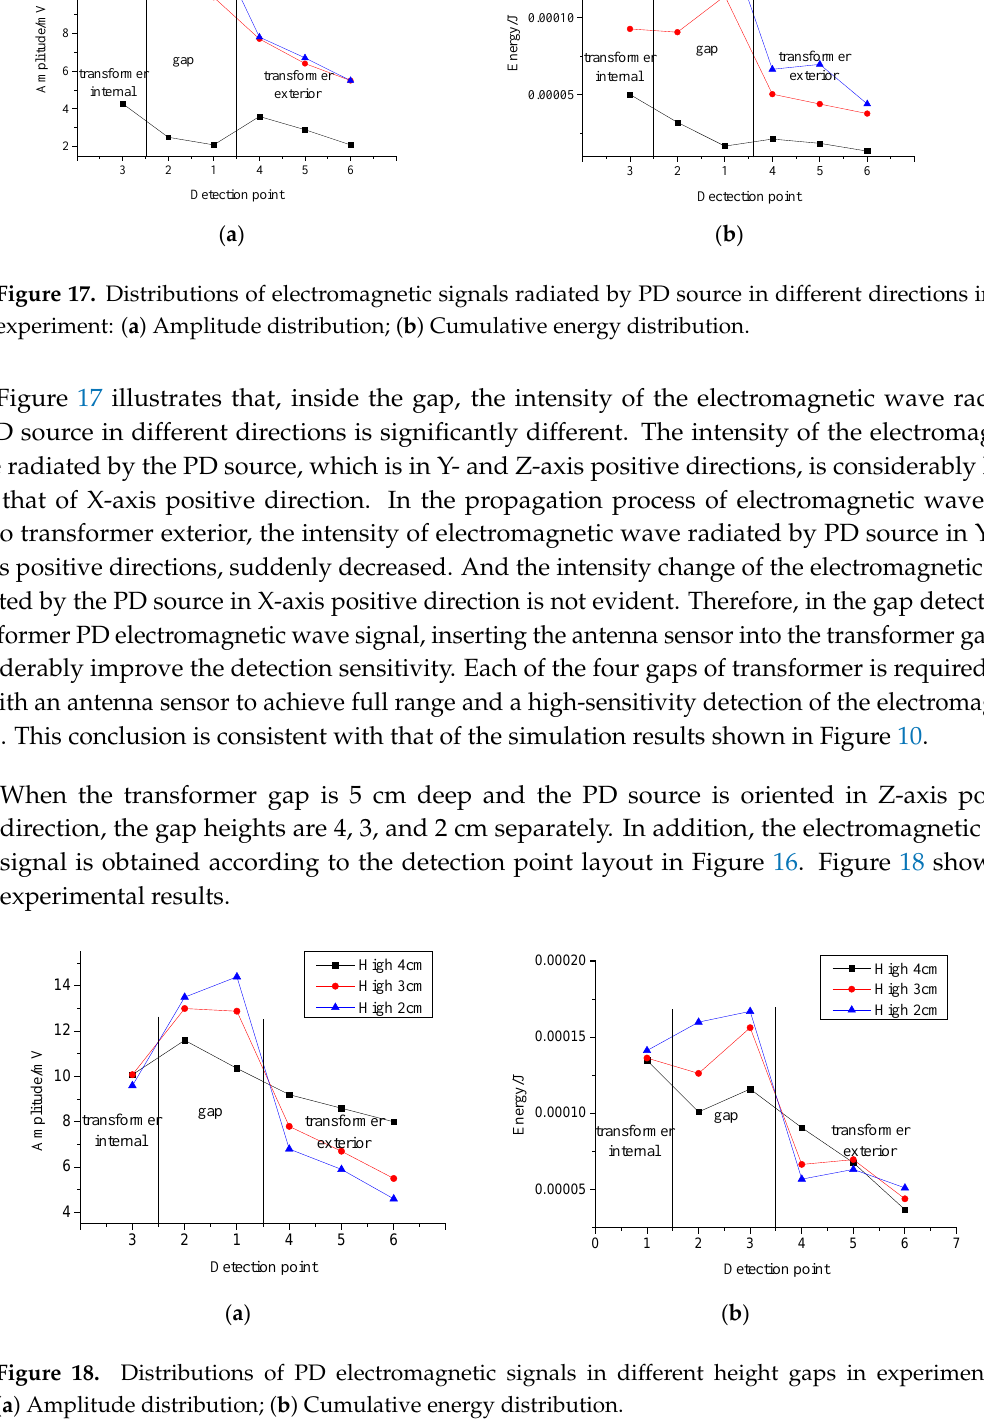
7 Figure 19. Layout of the detection point of experiment (transformer gap is (x + 4) cm high and 5 cm deep). Figure 20 illustrates that the propagation characteristics of electromagnetic waves in different depth gaps in the experiment are slightly different from the propagation characteristics of the electromagnetic wave in simulation experiment shown in Figure 13. In consideration of the existence of experimental errors, the following conclusions can still be drawn from the experimental results. Inside the gap, the intensity of the electromagnetic wave shows a gradually increasing trend with the decrease of gap depth. In addition, the intensity of electromagnetic wave has an increasing trend at the tail of gap.